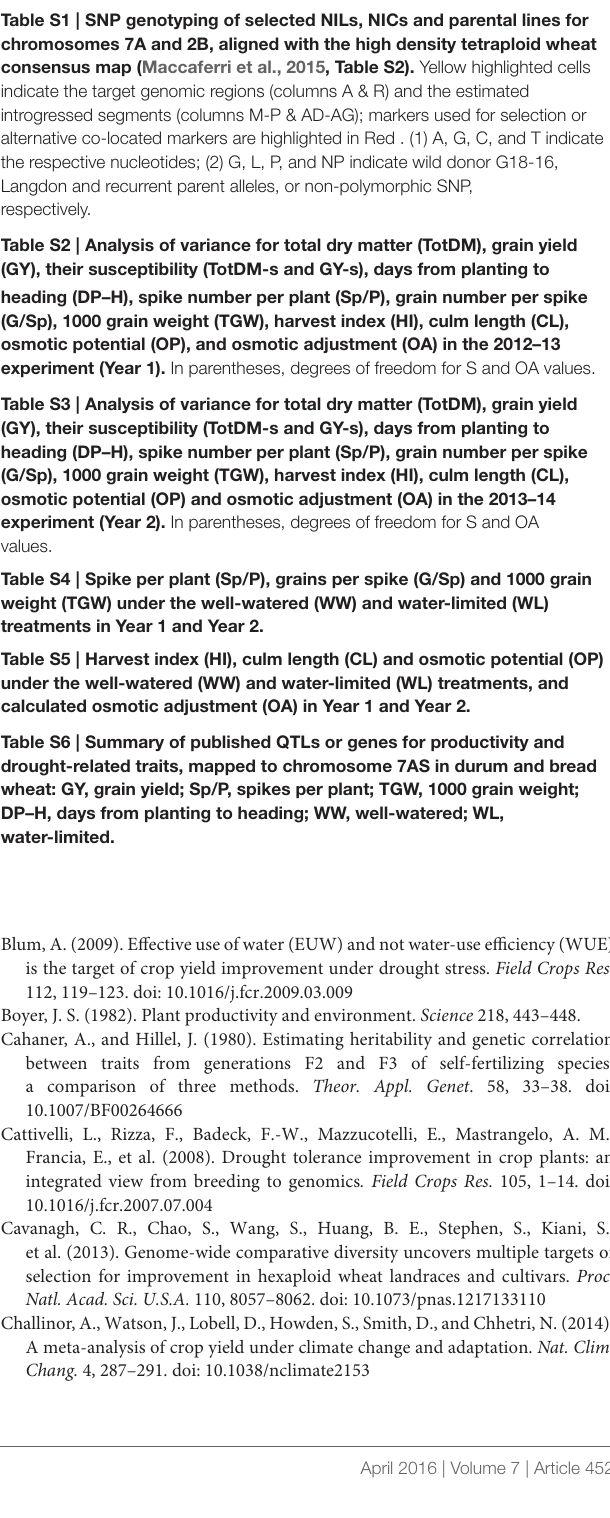
Figure S1 | Pedigree of the developed near-isogenic lines and near-isogenic controls. G and P designate the wild and domesticated alleles at the target region. Genotypes indicated by strikeout line were excluded from the backcross program. Table S1 | SNP genotyping of selected NILs, NICs and parental lines for chromosomes 7A and 2B, aligned with the high density tetraploid wheat consensus map (Maccaferri et al., 2015, Table S2). Yellow highlighted cells indicate the target genomic regions (columns A & R) and the estimated introgressed segments (columns M-P & AD-AG); markers used for selection or alternative co-located markers are highlighted in Red . (1) A, G, C, and T indicate the respective nucleotides; (2) G, L, P, and NP indicate wild donor G18-16, Langdon and recurrent parent alleles, or non-polymorphic SNP, respectively. Table S2 | Analysis of variance for total dry matter (TotDM), grain yield (GY), their susceptibility (TotDM-s and GY-s), days from planting to